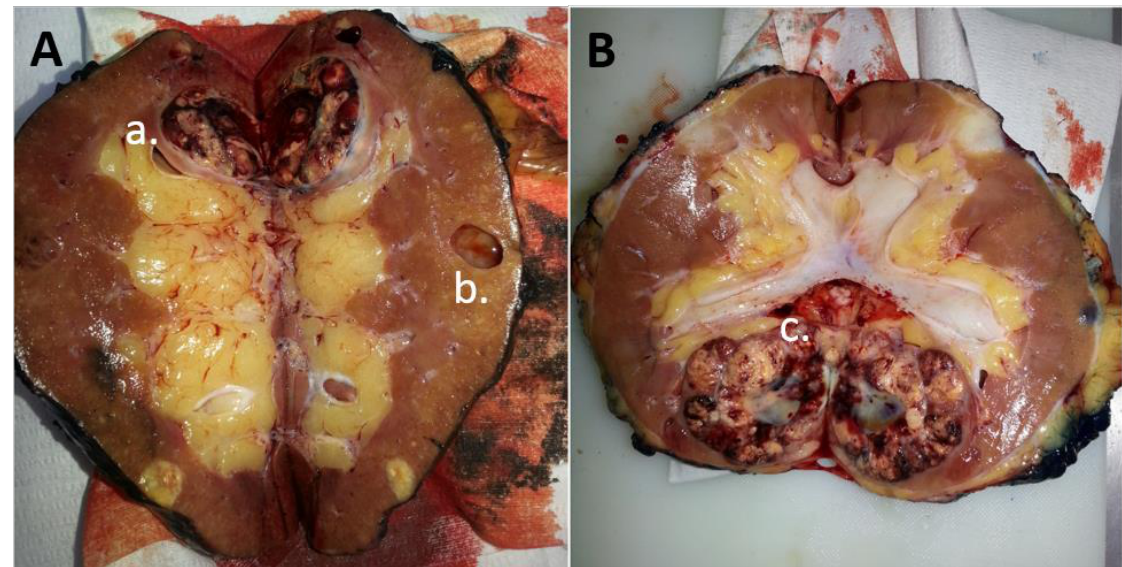
Figure 2. A . Bivalved allograft kidney, case 1: Primary lesion is clear-cell renal cell carcinoma (ccRCC) visible in upper pole (a.). Papillary adenomas not easily visualised. Cortical cyst visible (b.). B . Bivalved allograft kidney, case 2 : primary lesion (ccRCC) visible in lower pole (c.); note invasion into renal sinus fat.